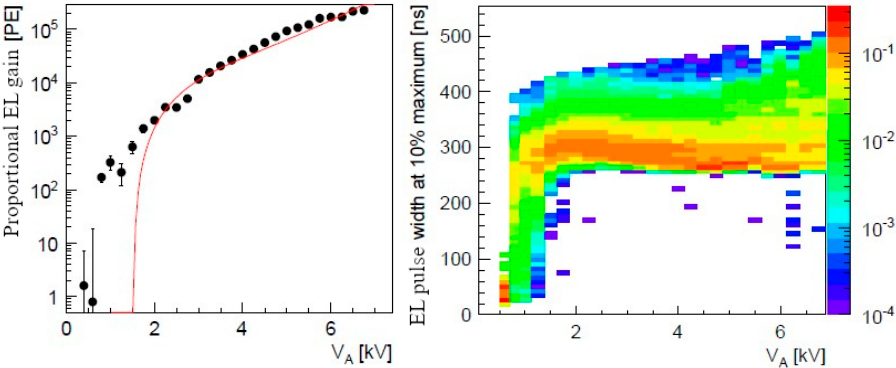
Figure 26. Left: proportional EL gain expressed in photoelectrons (PE) recorded by PMT as a function of applied voltage for 10 μ m anode wire in liquid Xe [30]. The curve is the linear fit to the data points. Notice that the experimental data points diverge from this fit near and below the nominal EL threshold. Right: the EL pulse width at 10% of pulse maximum as a function of applied voltage. Notice that the EL pulse width decreases below the nominal EL threshold, presumably indicating on alternative EL mechanism below the threshold.